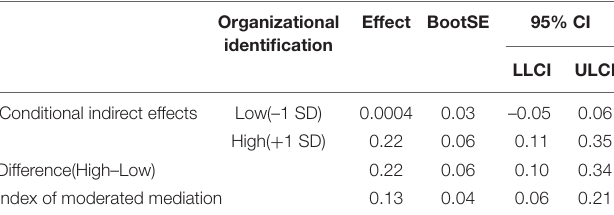
TABLE 6 | Moderated mediation results of organizational